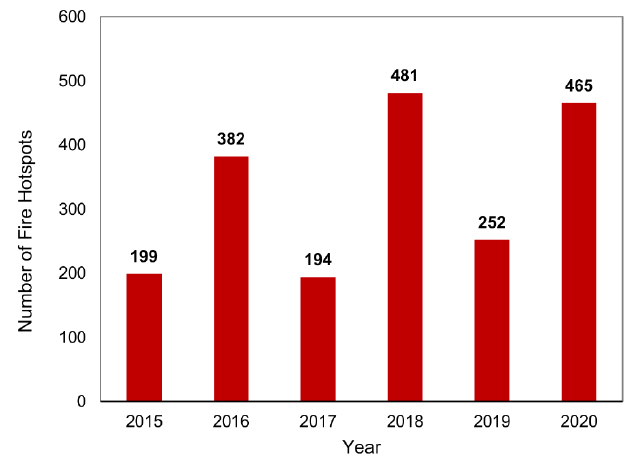
Figure 8. Number of fire hotspots in southeast Brazil during May of